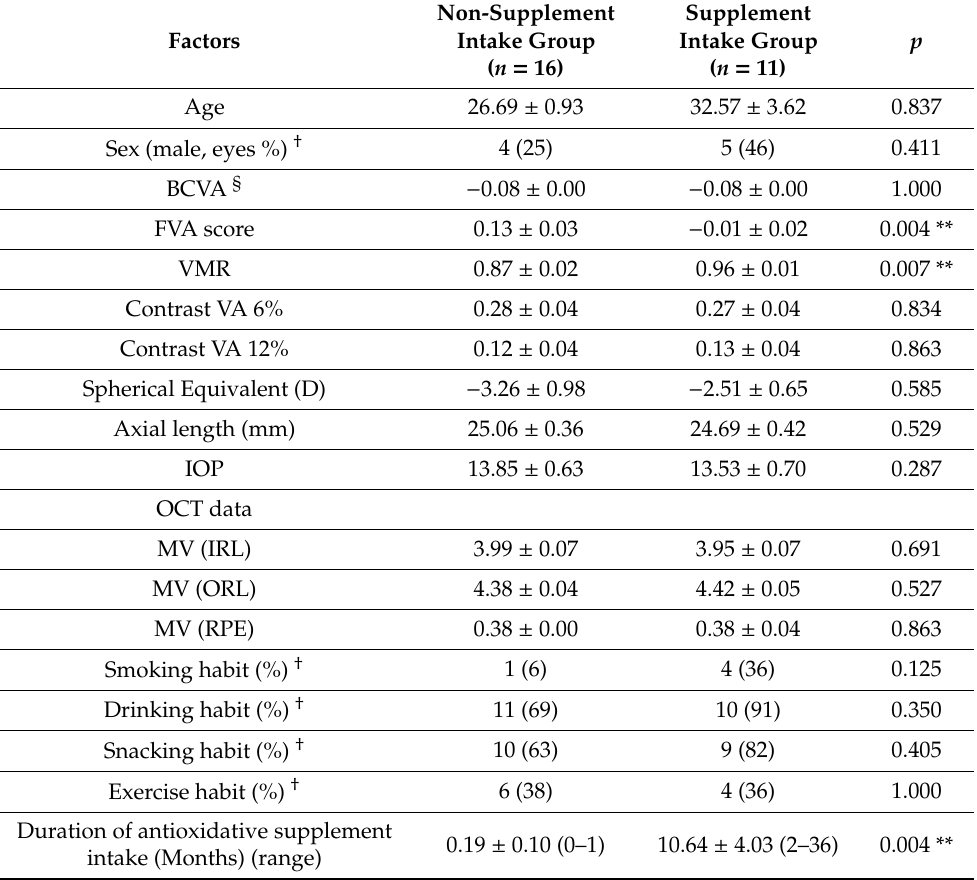
Table 3. Ocular data of the participants with or without antioxidative supplement